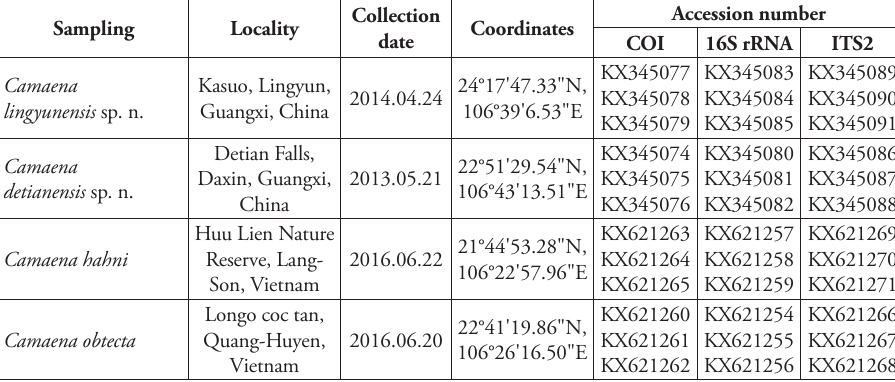
Table 2. Sampling information and GenBank accession numbers of some species.